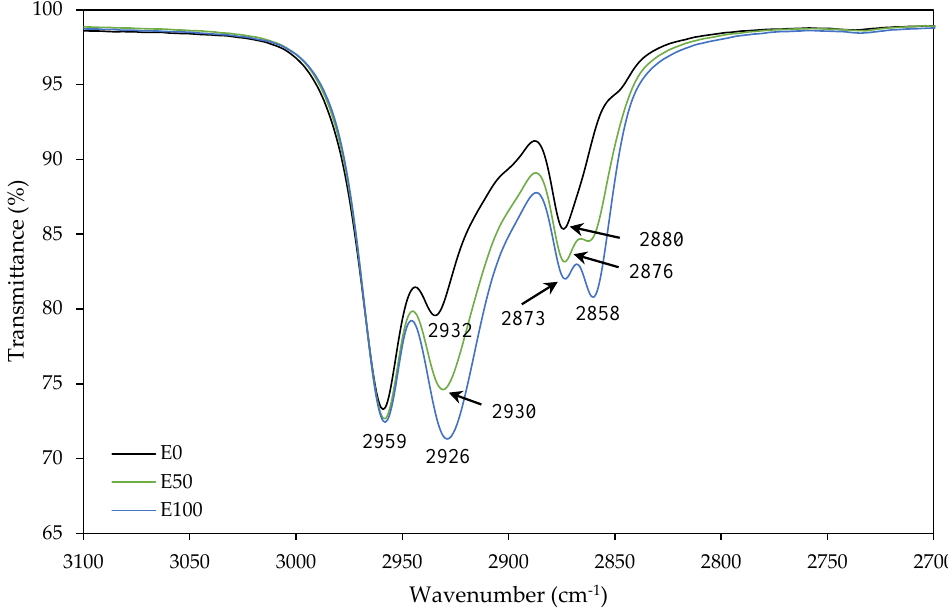
Figure 4. FTIR spectra of E0, E50 and E100 samples over a range of wavenumbers of 3100–2700 cm − 1 .